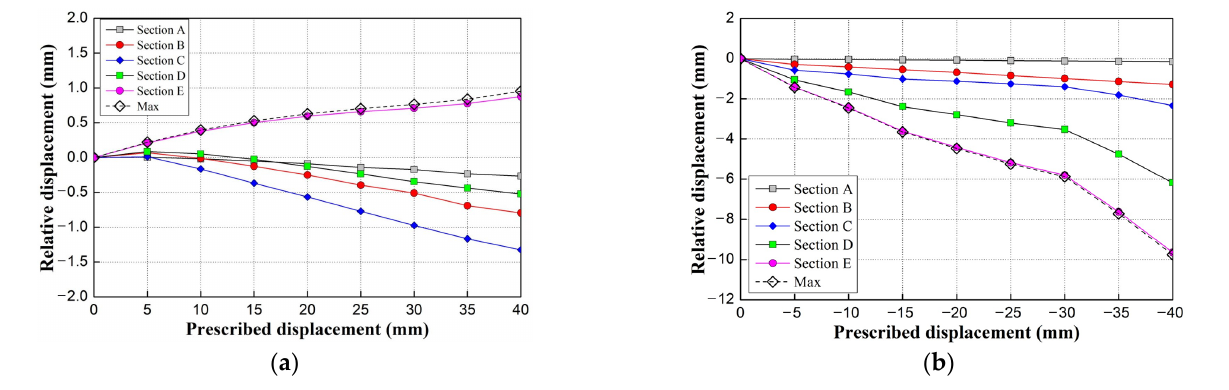
Figure 9. FE analysis results (relative displacement between rail and bed, z direction) according to magnitude of ( a ) uplift or ( b ) subsidence.